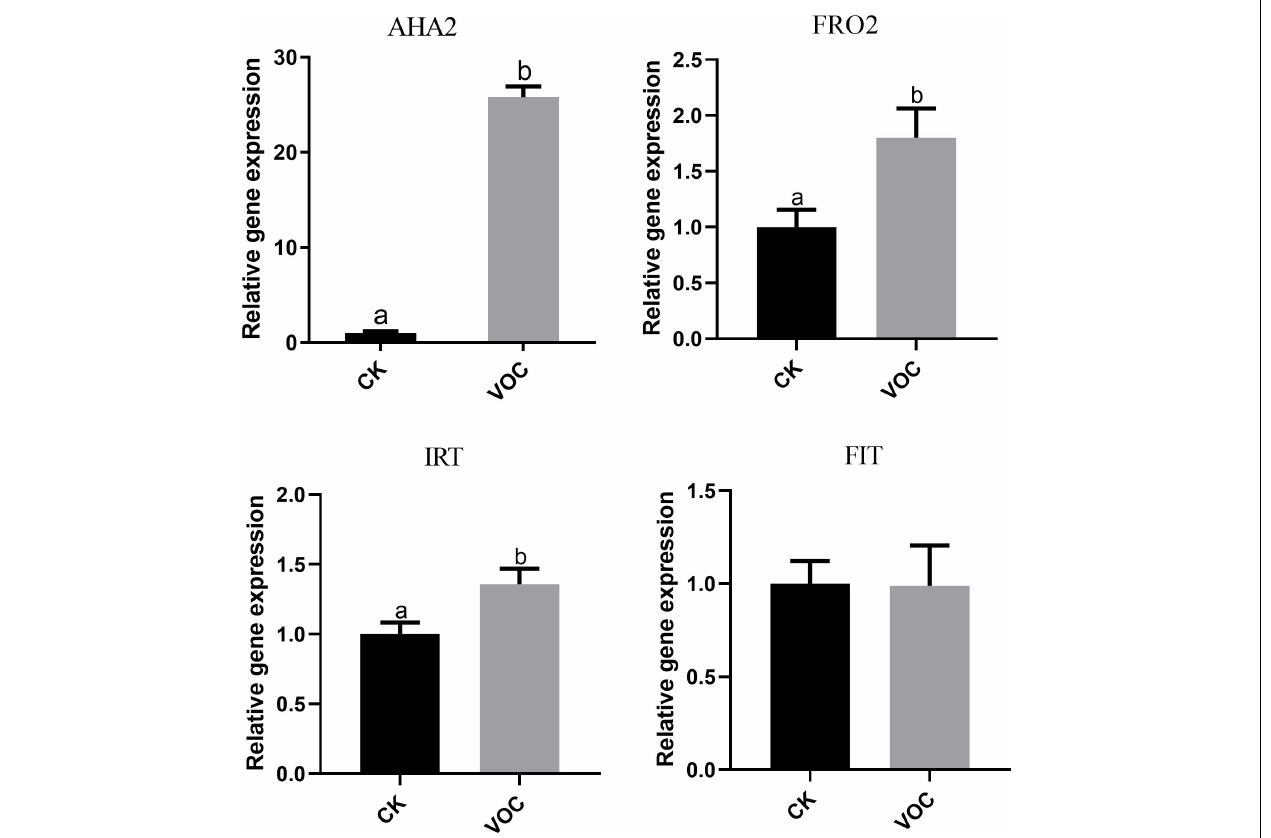
FIGURE 3 | Effects of VOCs from Rahnella aquatilis JZ-GX1 on the expression of the AHA2 , FRO2 , IRT1 , and FIT genes in Arabidopsis thaliana. One-way ANOVA was performed, and Duncan’s post hoc test was applied. Different letters indicate statistically significant differences ( p < 0.05) among